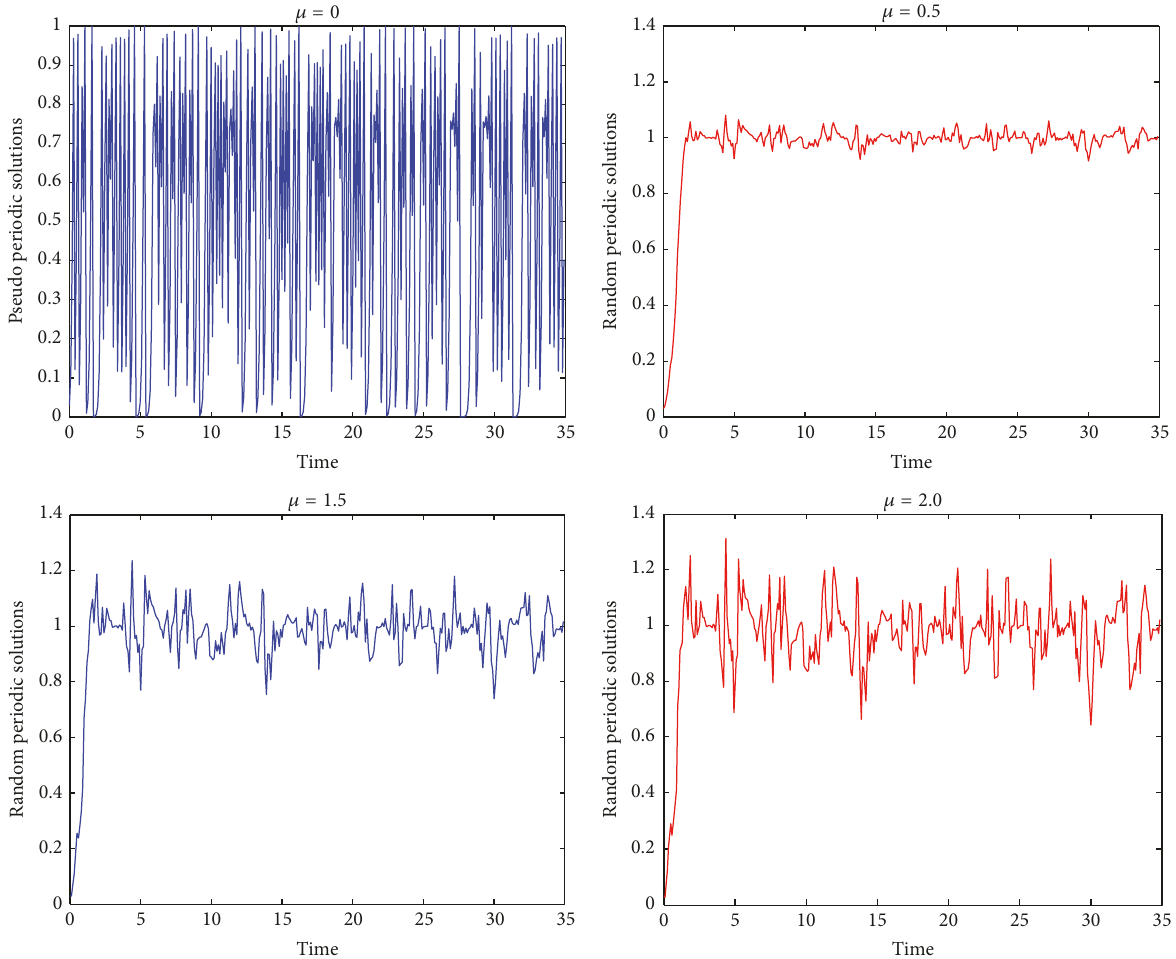
Figure 3: Pseudoorbits for different sizes of noise: 𝜇 = 0 , 𝜇 = 0.5 , 𝜇 = 1.5 , and 𝜇 = 2.0